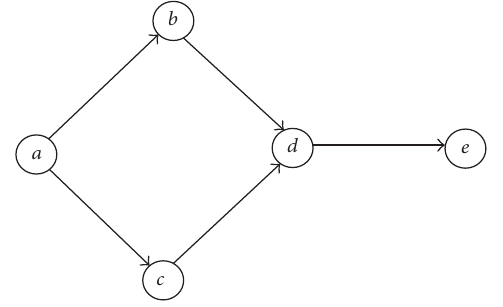
Figure 1: The graph associated to relation 𝑅